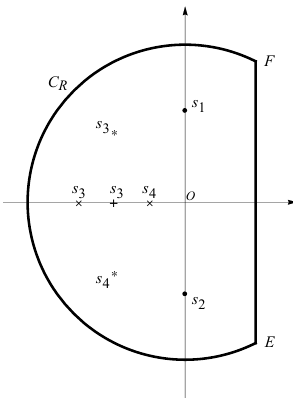
Figure 3. Contour in the integer-order case.